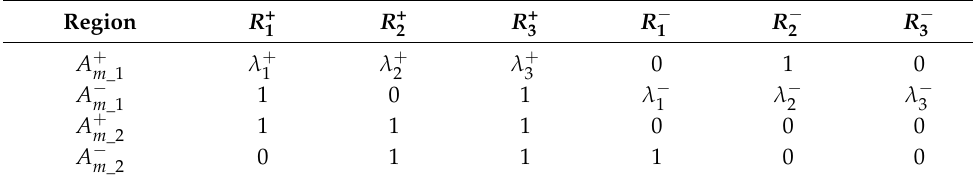
Table 3. The modulation signals in Case 2.